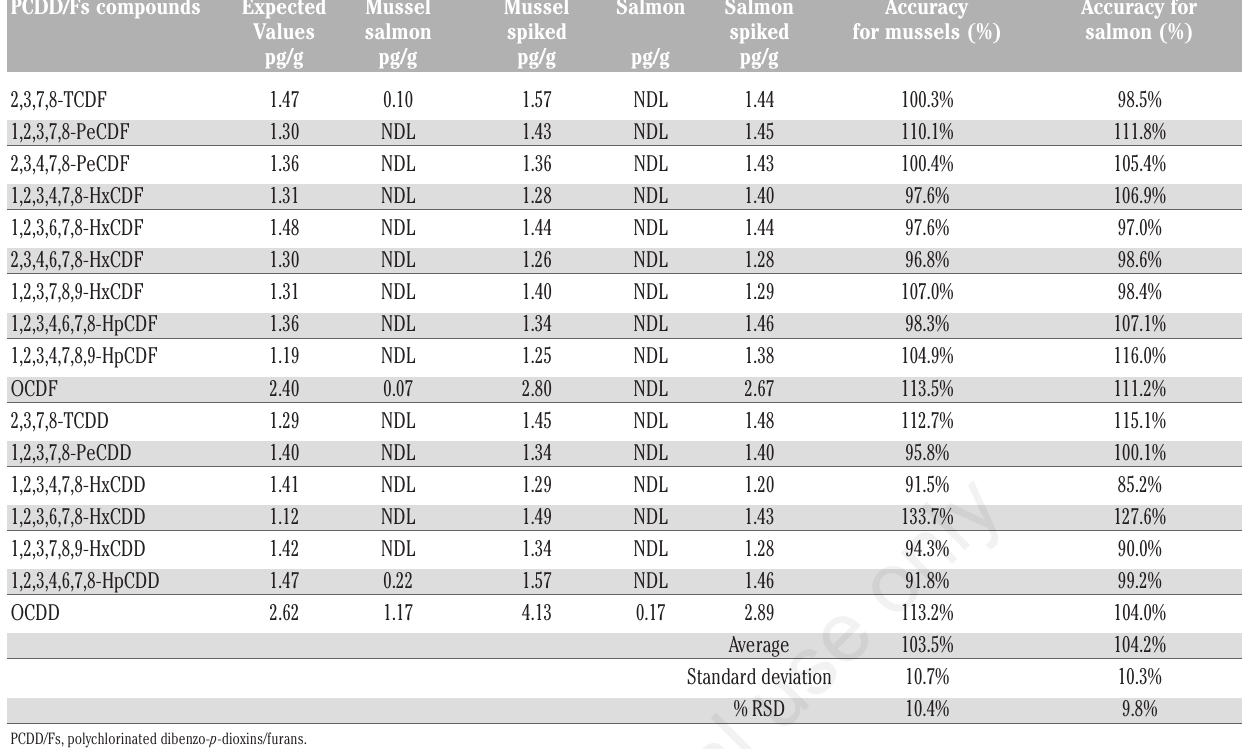
Table 1. Accuracy of the targeted polychlorinated dibenzo- p -dioxins/furans spiked in mussels and salmon. PCDD/Fs compounds